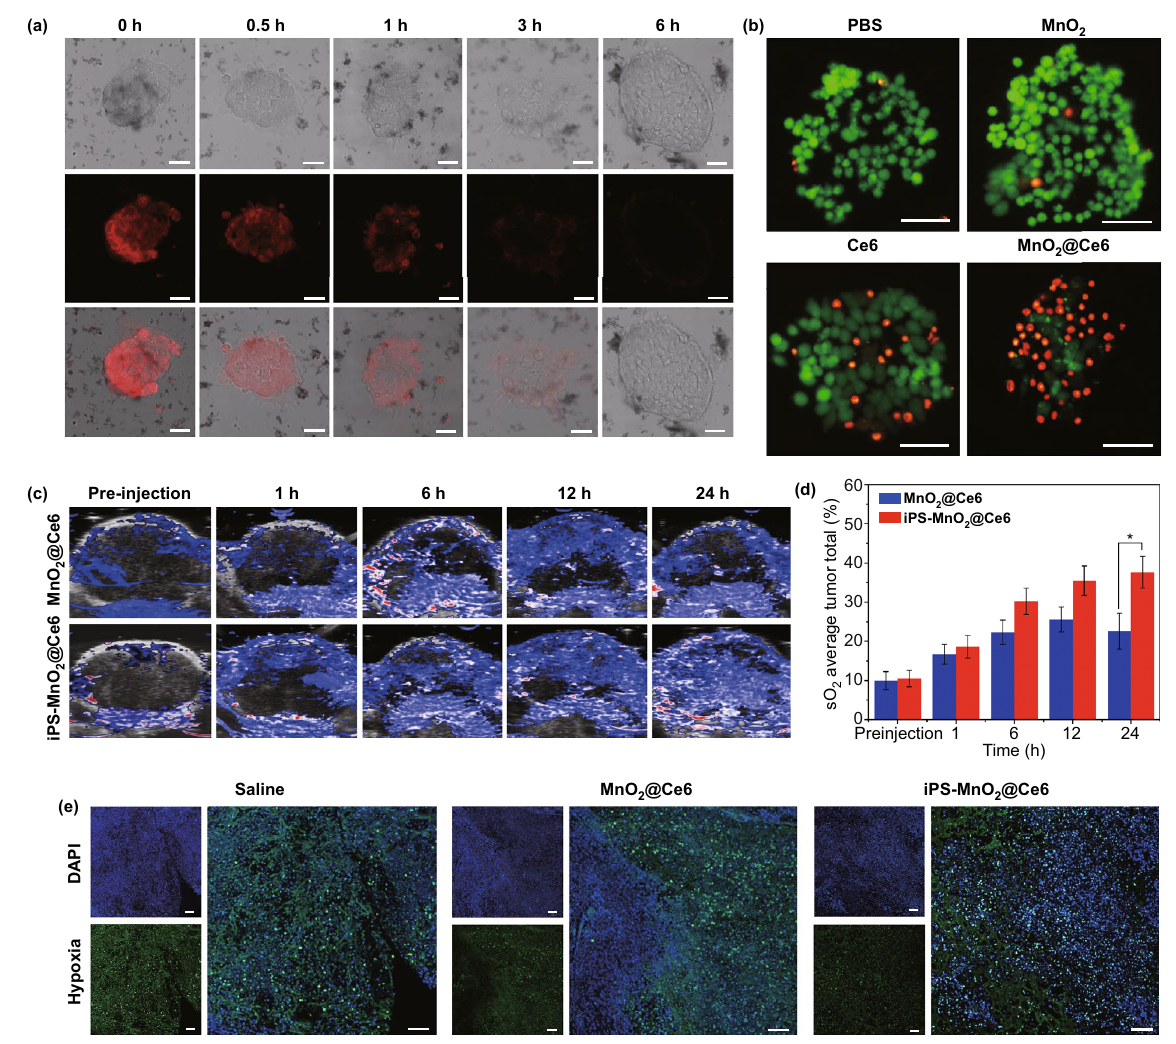
Fig. 3 The excellent biological properties of iPS-MnO 2 @Ce6. a Confocal laser microscopy images of oxygen-sensing probe ([(Ru (dpp) 3 )] Cl 2 ) in iPS cells showing the intracellular oxygen level incubated with nanoprobes for the indicated time. Scale bars are 50 μm. b Fluorescence images of Calcein AM (green)/PI(red) stained iPS cells incubated with free Ce6, MnO 2 , and nanoprobes. Scale bars are 50 μm. c Photoacoustic imaging showing saturated O 2 (sO 2 ) levels in tumors after injection of MnO 2 @Ce6 and iPS-MnO 2 @Ce6 at different time points. d The quanti- fied tumor oxygen saturation levels calculated from c . Data were expressed as mean ± SD, ( n = 3, * P < 0.05). e Representative immunofluores- cence images of tumor sections after hypoxia staining. The nuclei and hypoxia regions were stained by DAPI (blue) and anti-pimonidazole anti- body (green), respectively. Scale bars are 100 μm. (Color figure